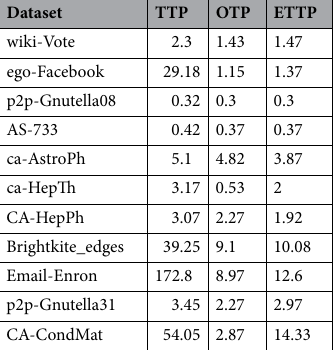
Table 3. Running times of all algorithms in a single node in Hadoop (min).